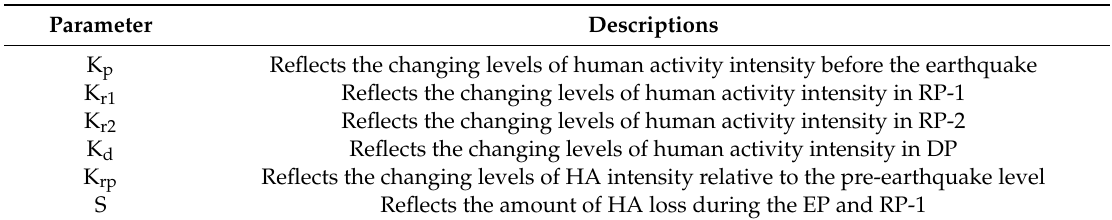
Table 1. PNLP pattern parameter